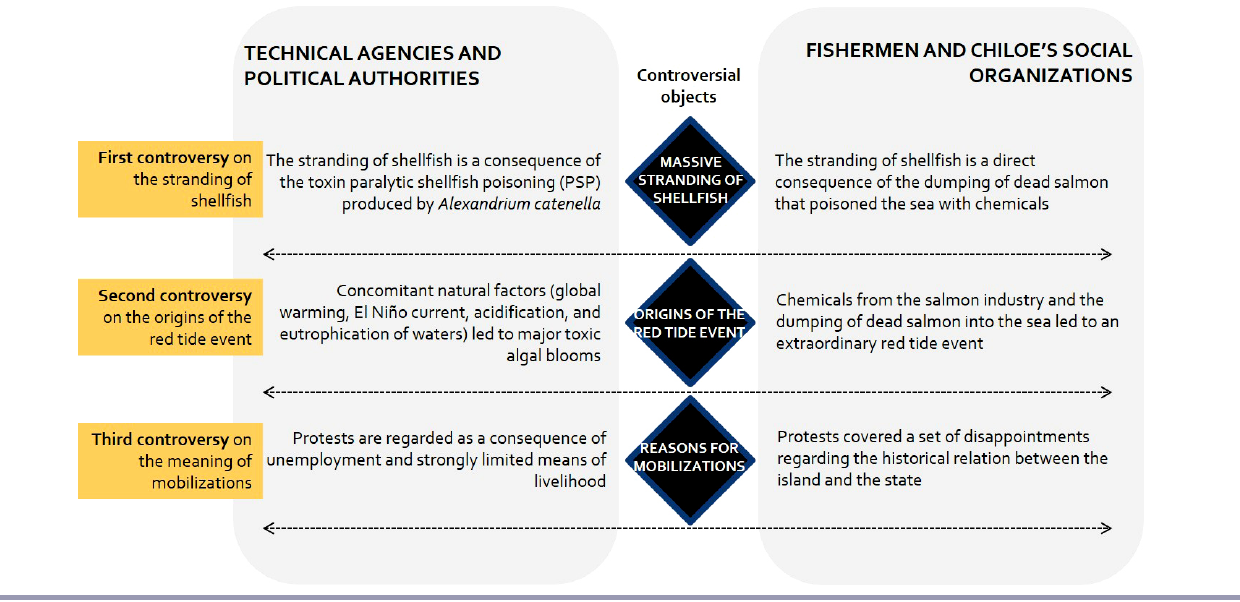
Fig. 2 . Controversies in the Chiloe red tide